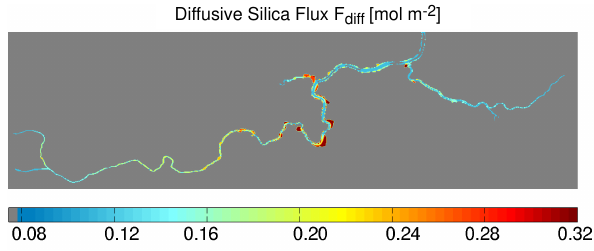
Fig. 11. Distribution of integrated (June–November 2003) diffu- sive silica fluxes F diff in the tidal freshwater reaches of the Scheldt